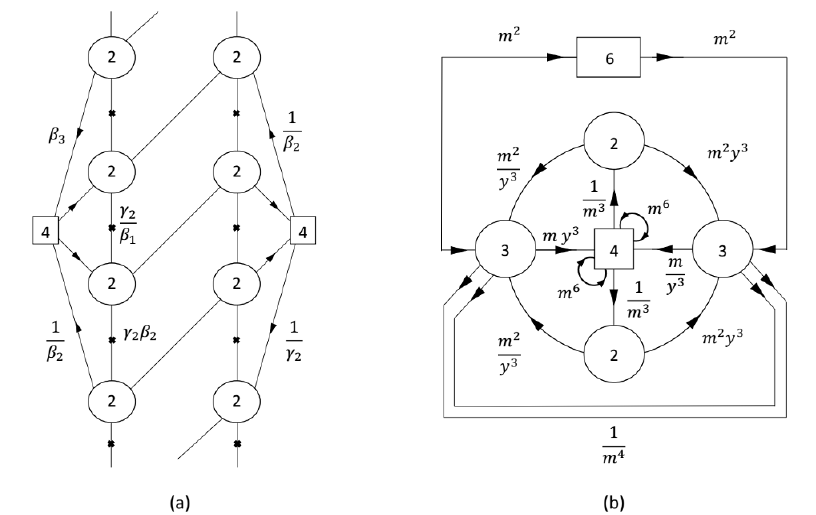
Figure 32 . Two theories expected to be dual since they both describe the same compacti(cid:12)cation of the minimal ( D 5 ; D 5 ) conformal matter. (a) The theory constructed from the tubes II and III that we introduced previously. We have written some of the charges of the (cid:12)elds via fugacities, the rest can be inferred from anomalies and the superpotentials. (b) The theory constructed from USp(2 k ) = SU( k + 1) domain wall discussed in [11]. Here we used the simpler version given